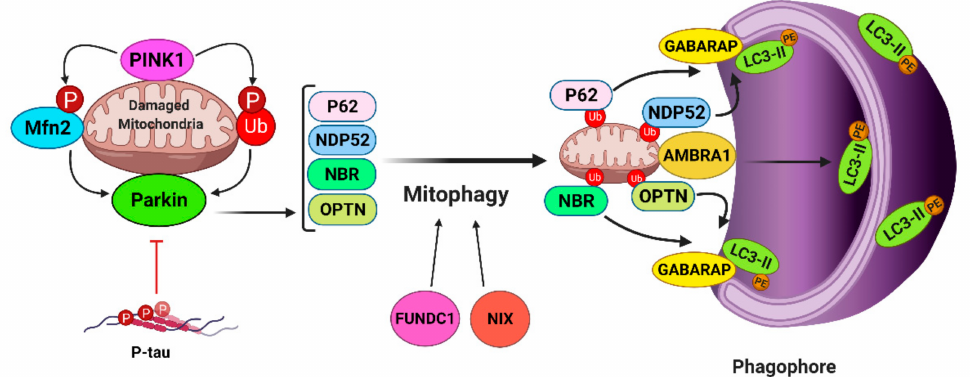
Figure 4. Mitophagy; mitochondria targeting. During mitochondrial dysfunction, PINK1 is localized on the outer mito- chondrial membrane. PINK1 activates Mfn2 as well as Ubiquitin molecules by phosphorylation, leading to the recruitment of Parkin an E3 ubiquitin ligase. Then, Ubiquitin binding mitophagy receptors such as P62, NDP52, NBR, and OPTN act as adaptor proteins and direct mitochondria into the expanding phagophore through covalently binding to LC3 and GABARAP. While hyperphosphorylated tau (p-tau) is found to block mitophagy by inhibiting Parkin, NIX and FUNDC1 proteins are inducers of mitophagy. AMBRA1 can also promote mitophagy by binding to